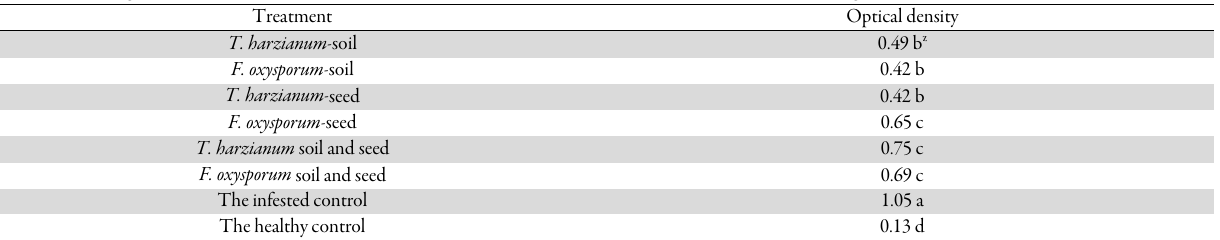
Table 3. Efficacy of a combination of the main (different application methods of T. harzianum strain 908 and F. oxysporum strain Fo47) and the sub- factor (two antagonists: T. harzianum and F. oxysporum ) in the suppression of BNYVV multiplication in greenhouse